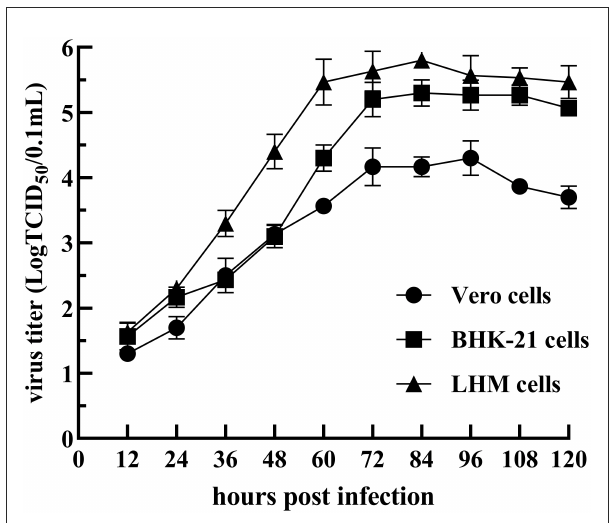
FIGURE2 CPE of NDRV-FJ19 strain at 72h post infection in the three cell lines.